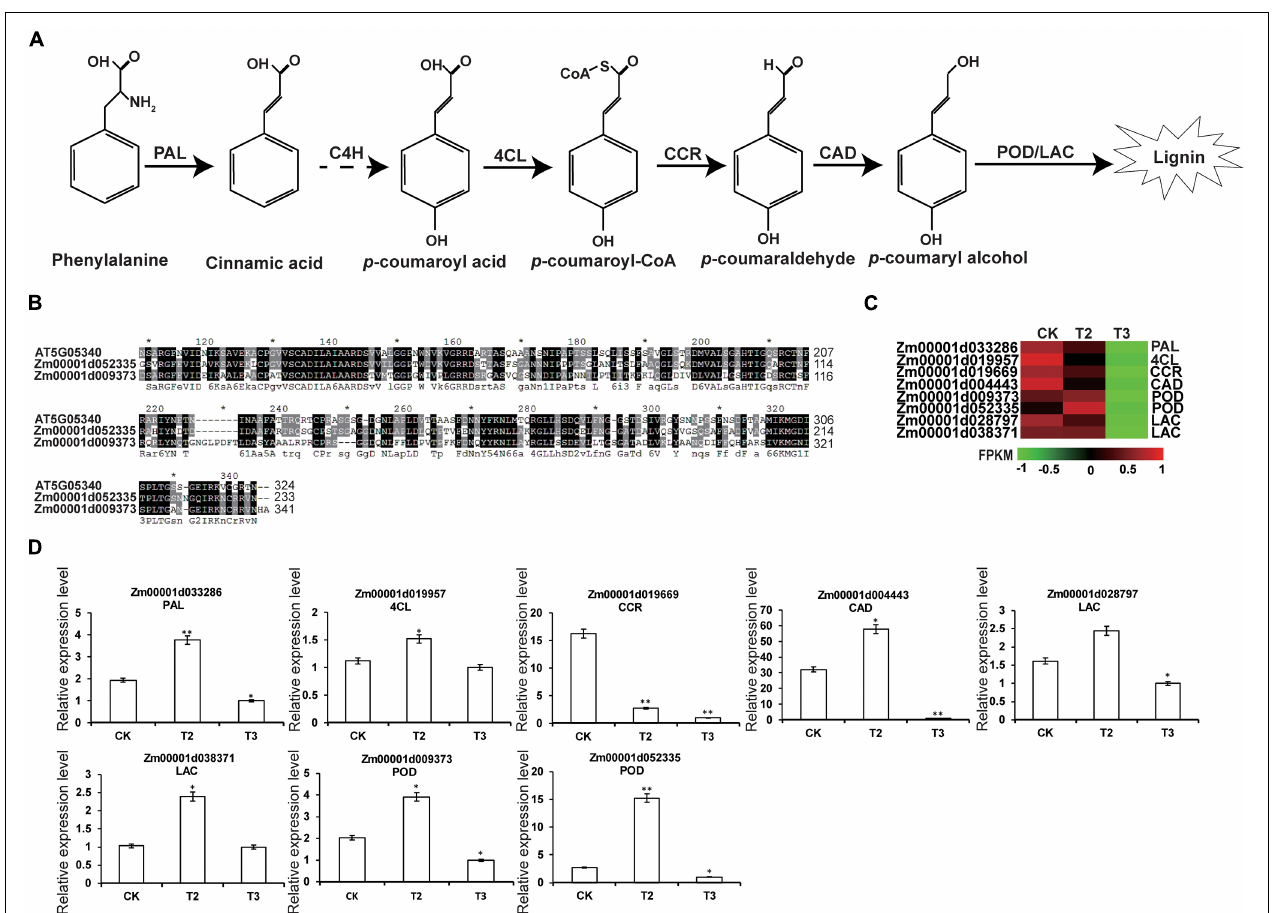
FIGURE 7 | Expression profiling of DEGs related to lignin biosynthesis. (A) Biosynthesis pathway of lignin (Boerjan et al., 2003). Solid arrows and dotted arrows represent known and undiscovered parts of the pathway. PAL, phenylalanine ammonia-lyase; C4H, cinnamate 4-hydroxylase; 4CL, 4-coumarate-CoA ligase; CCR, cinnamoyl-CoA reductase; CAD, cinnamyl alcohol dehydrogenase; POD, peroxidase; and LCC, laccase. (B) Multiple sequences alignment of AtPOD (At5G05340) and ZmPOD (Zm00001d052335 and Zm00001d009373). (C) Expression heatmaps for DEGs (CK, T2, and T3) involved in lignin biosynthesis. The heatmap was constructed using the FPKM, and the color from green to red represents the gene expression levels from low to high. (D) DEGs involved in lignin biosynthesis are verified by qRT-PCR. The statistical significance was determined using SPSS 16.0 with a one-way analysis of Tukey’s test. ∗ represents p ≤ 0.05; ∗∗ represents p ≤ 0.01. The x-axis represents Se application treatments (CK, T2, and T3), and the y-axis indicates the relative expression levels. Error bar shows the SEs of three biological